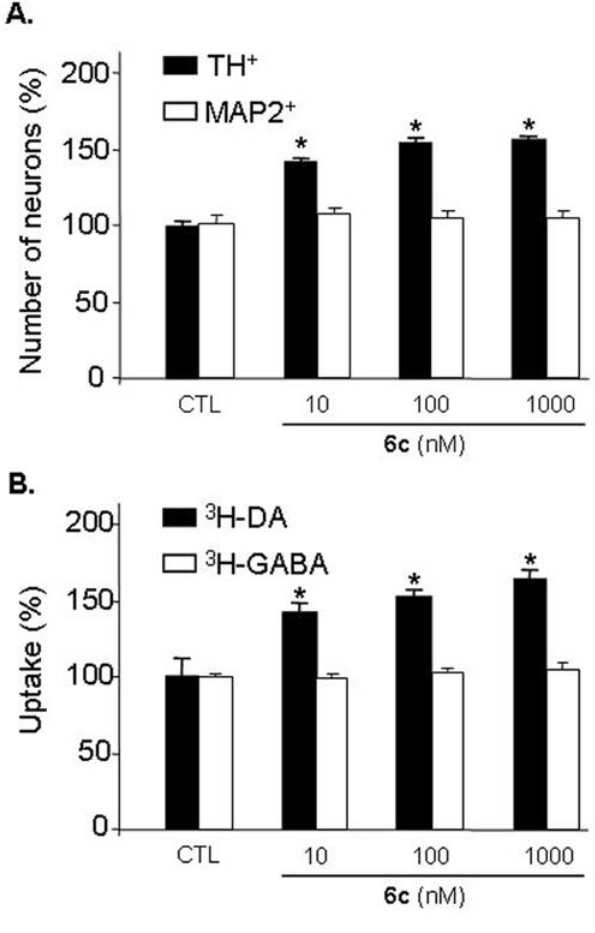
Figure 3. Specificity of compound 6c-induced neurotrophic effect on DA neurons. (A) The number of DA and total neurons in 6c - treated cultures was evaluated by counting of TH and MAP-2 immunolabeled neurons. The treatment with compound 6c has no effect on the viability of MAP-2 + neurons, while the number of TH + neurons wa significantly increased in a dose-dependent manner. (B) [ 3 H]-DA and [ 3 H]-GABA uptake in 6c -treated cultures. Compound 6c had no effect on [ 3 H]-GABA uptake, while [ 3 H]-DA uptake was significantly increased in a dose-dependent manner showing the specificity of the effect of compound 6c on DA neurons in these conditions. Values are normalized to the untreated control (CTL) and represent the average of at least three assays performed in triplicate and are expressed as mean 6 SEM. *P , 0.001. Statistical analysis was performed by one-way ANOVA followed by Bonferroni’s post hoc